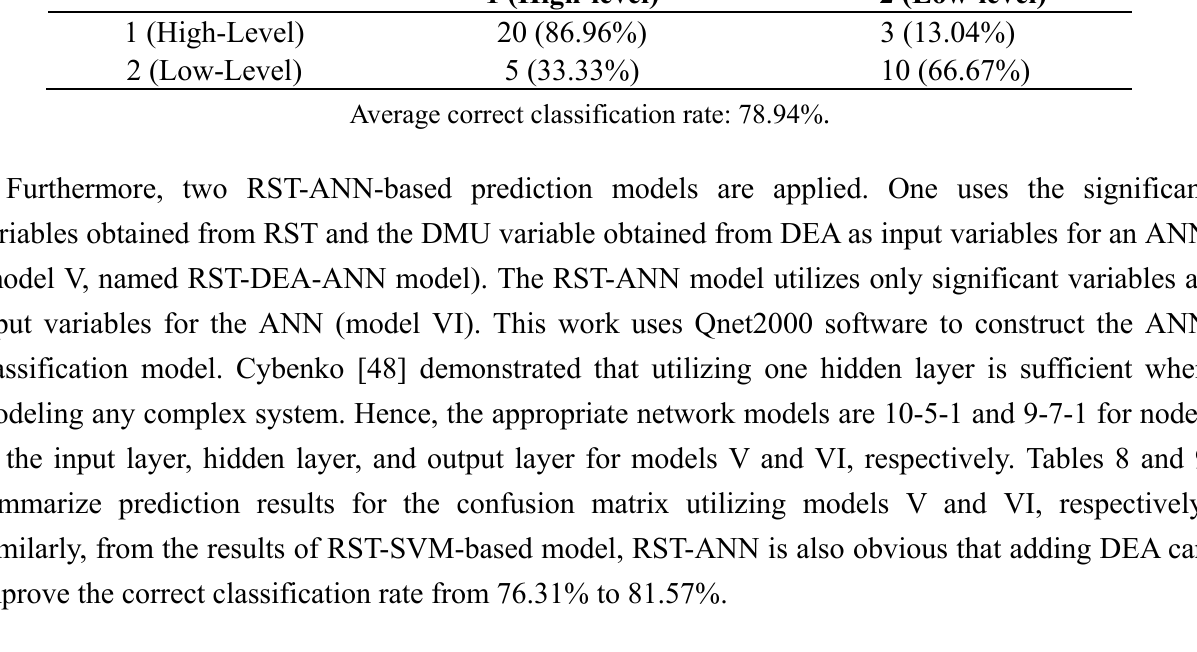
Table 8. RST-DEA-ANN model (model V) results with both significant variables and DMU.